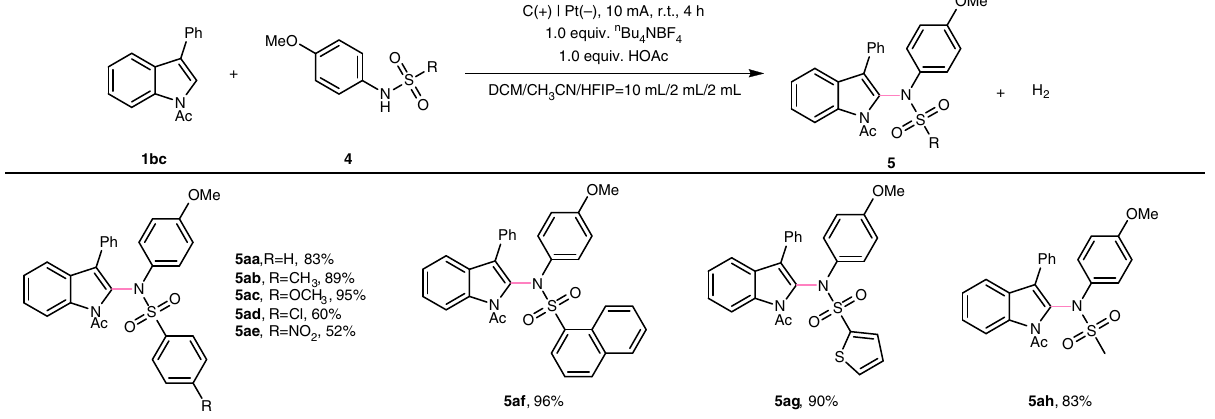
C(+) | Pt(–), 10 mA, r.t., 4 h 1.0 equiv. n Bu 4 NBF 4